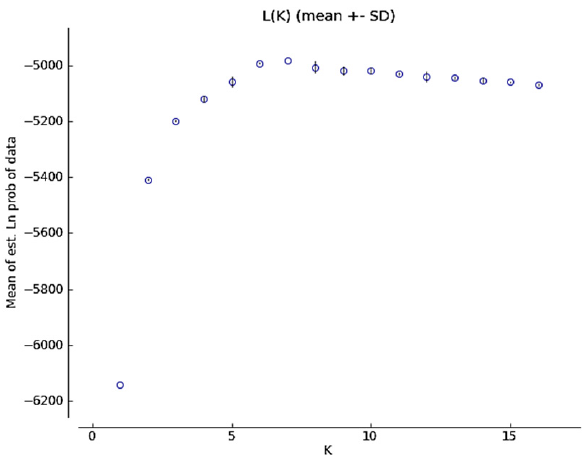
Figure A2. Mean Ln(K) plot for the Northern Zone.